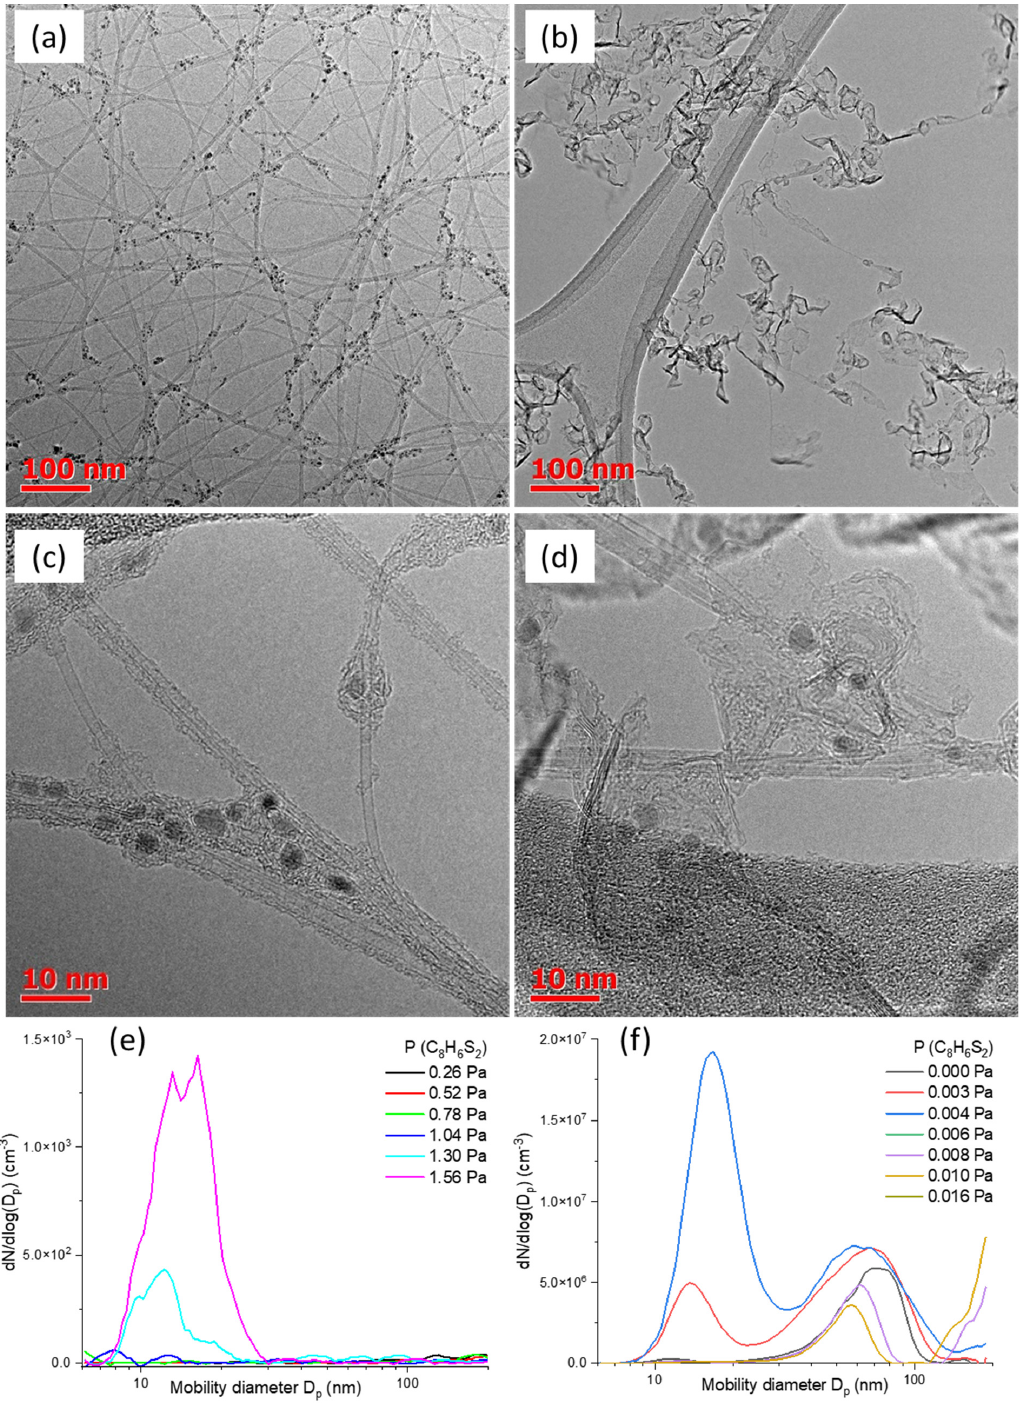
Figure 3. Typical TEM images of carbon nanotubes produced ( a , c ) without bithiophene and ( b , d ) with 0.08 Pa of bithiophene. DMA number size distributions of aerosol particles produced when bithiophene is supplied ( e ) in pure nitrogen and ( f ) in the ferrocene-CO mixture adjusted for SWCNT growth with the same residence time at 1000 °C.